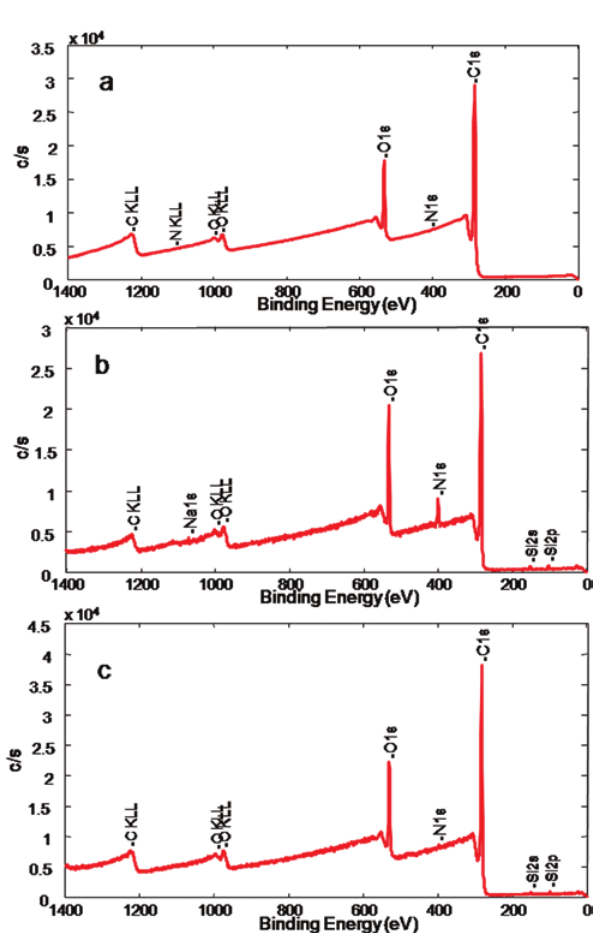
Fig. 3: XPS survey spectra of PEEK without modification (a), PEEK modified in He+N 2 atmosphere (b) and PEEK modified in N 2 O